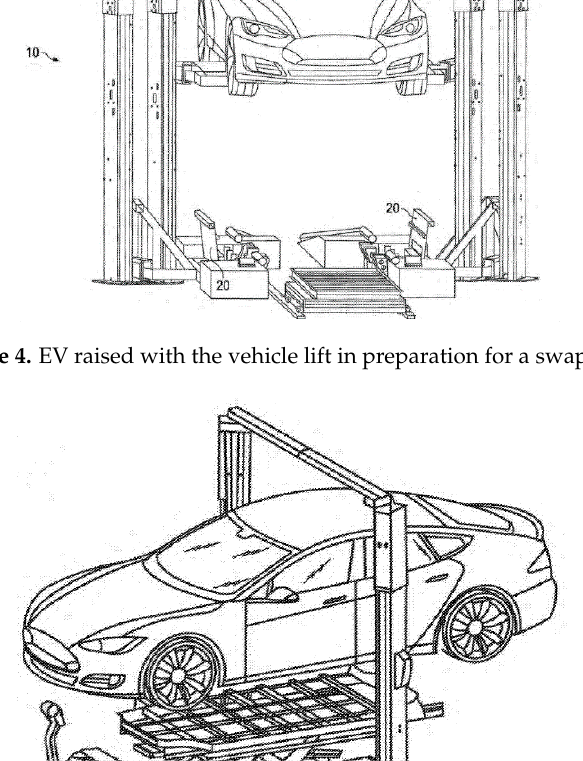
Figure 5. Battery lift lowering the depleted battery from the EV [15].